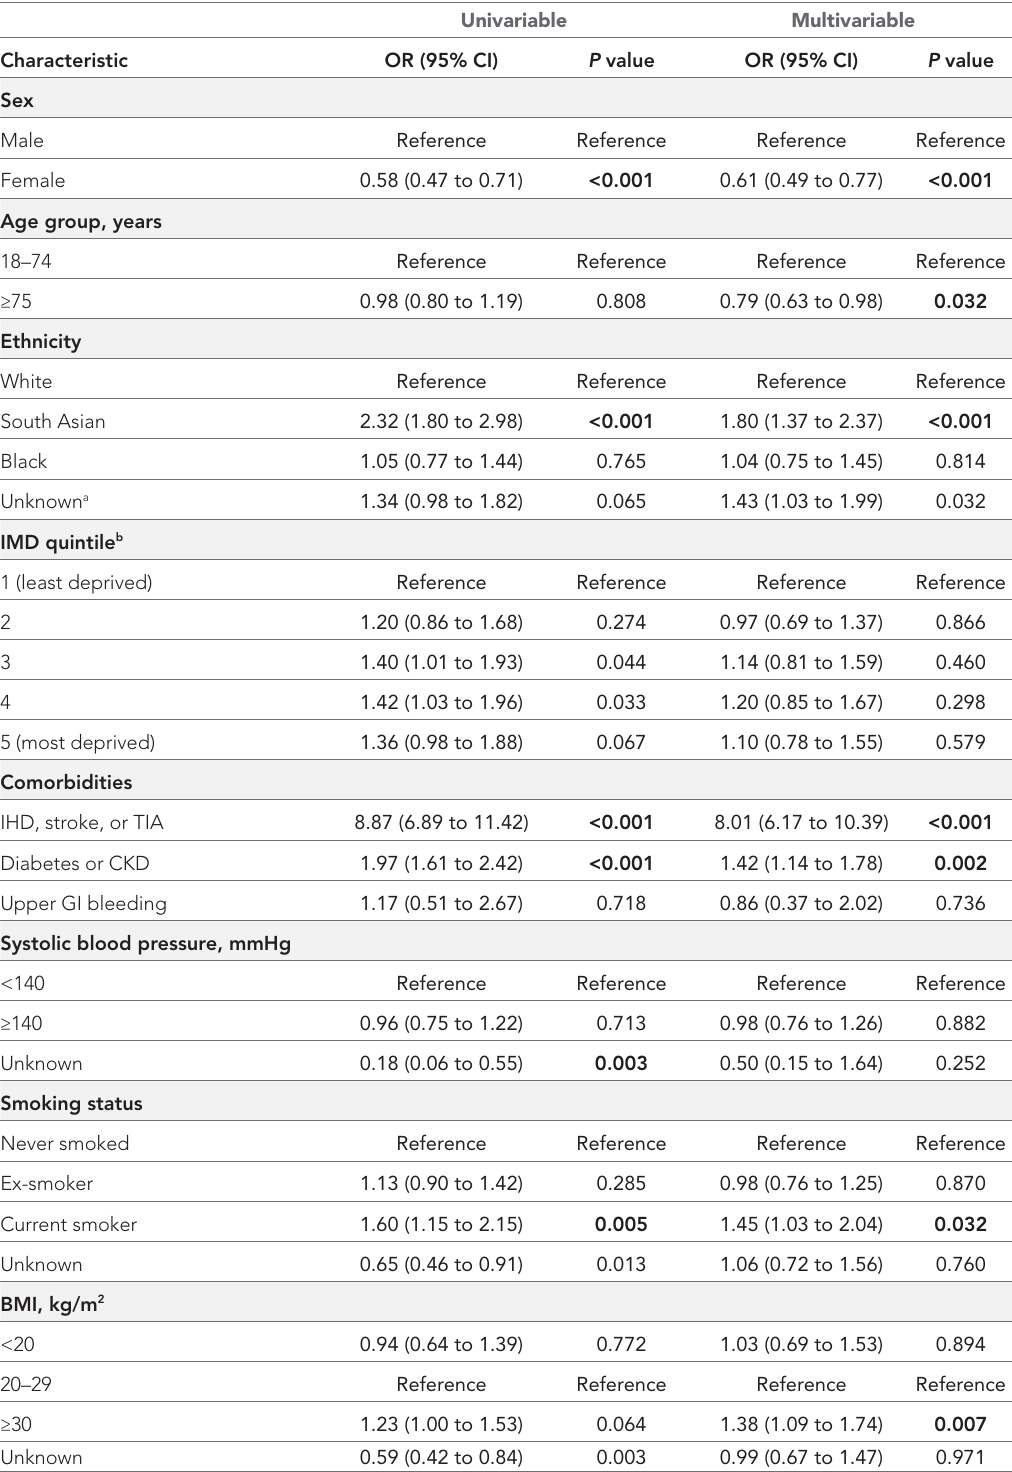
Table 2 Logistic regression models estimating the association of patient- related factors with DAT prescription among individuals with AF